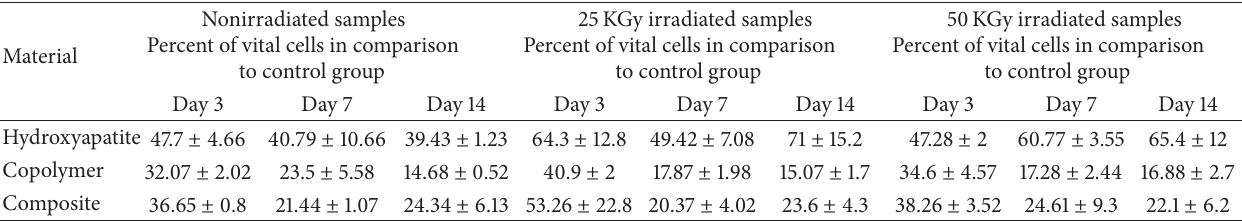
Table 5: Detailed results of MTT assay (percent of vital cells in comparison to control group) for hydroxyapatite, copolymer, and composite under 0, 25, and 50 KGy doses of gamma irradiation in days 3, 7, and 14.